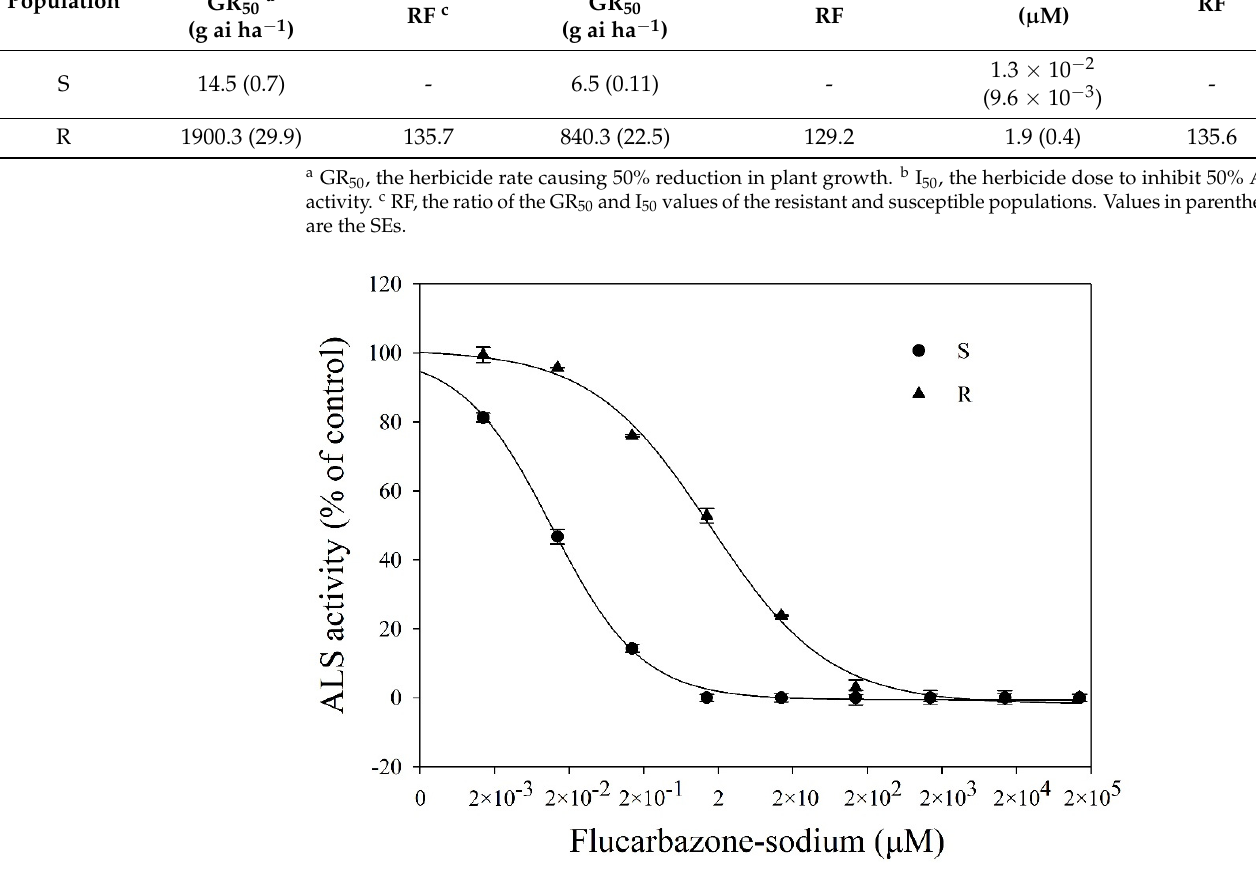
Table 1. GR 50 and I 50 values of B. japonicus populations treated with flucarbazone-sodium.